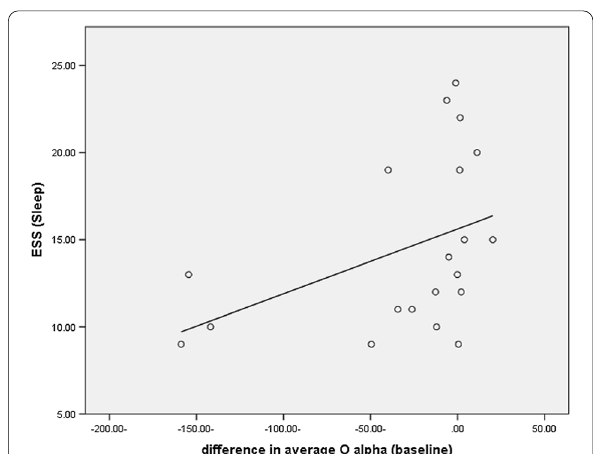
Fig. 1 Positive significant correlation between the difference of EEG (Average Occipital O alpha) before and after sleep with ESS in the cases. ( P 0.022) =